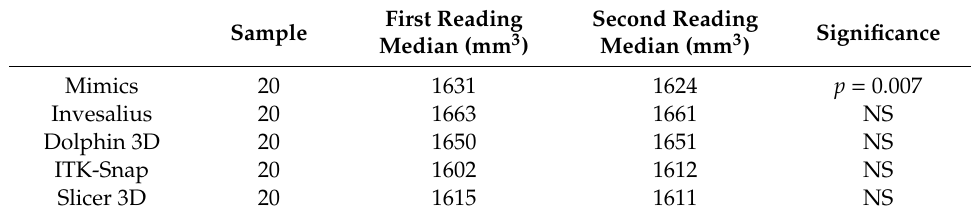
Table 4. Comparison between first and second volumetric readings of condylar models for each software (intra-observer reliability). Significance set at p < 0.05 according to the Wilcoxon Signed-Rank Test.